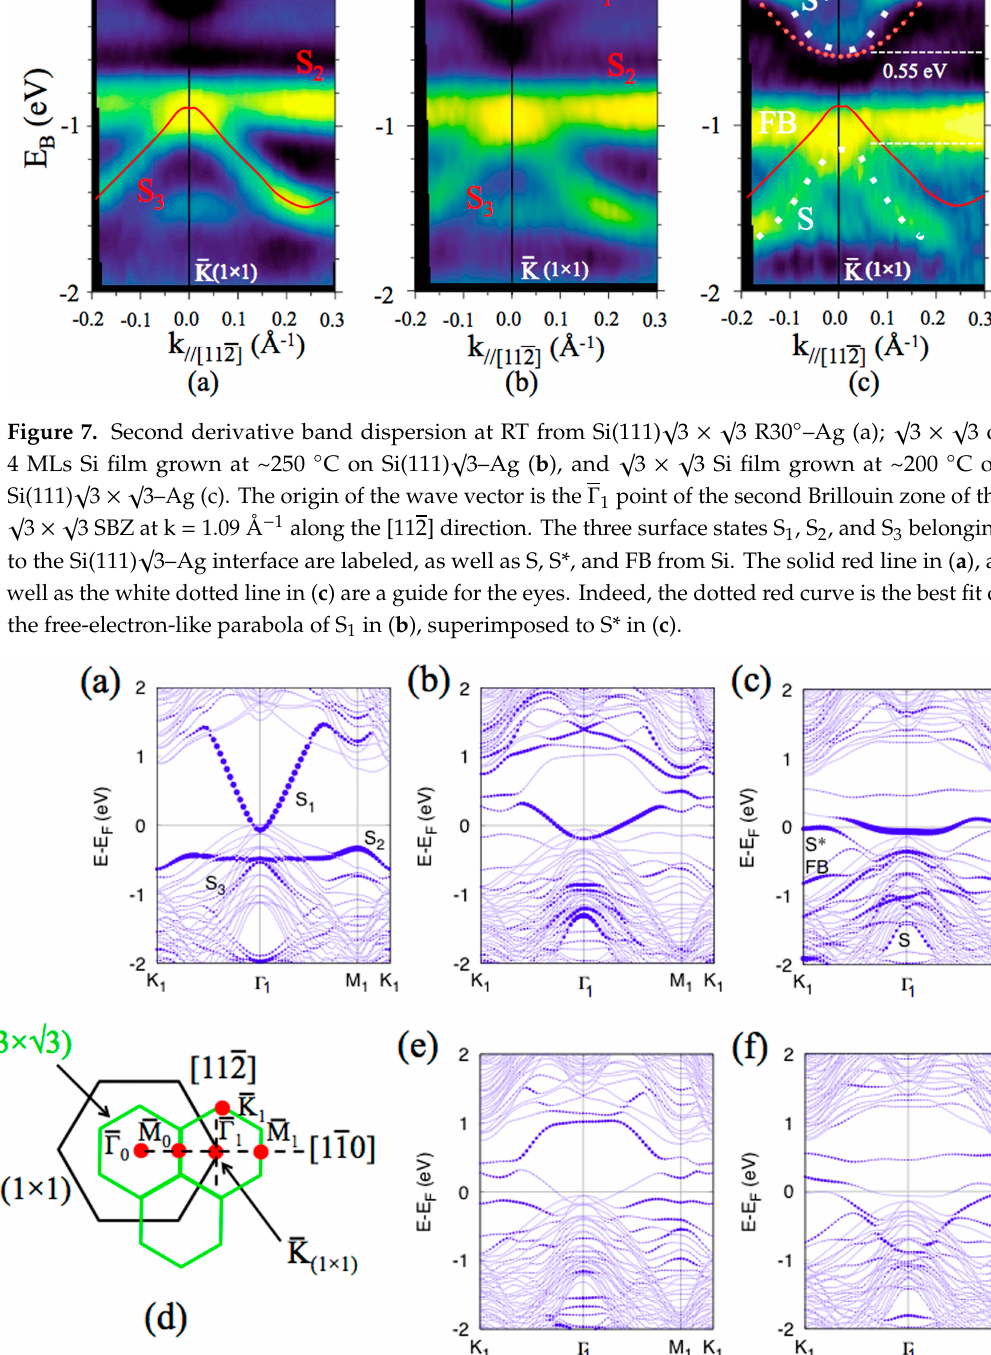
√ √ Figure 8. Calculated band structure of the bare 3 × 3 structure projected on Ag atoms ( a ), S 1 , S 2 , and S 3 are marked; multilayer silicene model B1 projected on top Si layer ( b ) and on Ag ( e ); DP4 model projected on top Si layer ( c ), S*, FB, and S are labeled, and on Ag atoms ( f ). B1 and DP4 models are √ √ reported in reference [1]. Brillouin zones of 3 × 3 and (1 × 1) are shown in ( d ), as well as the Γ 0 , M 0 , Γ 1 , M 1 high symmetry points, and [112], [110] directions are